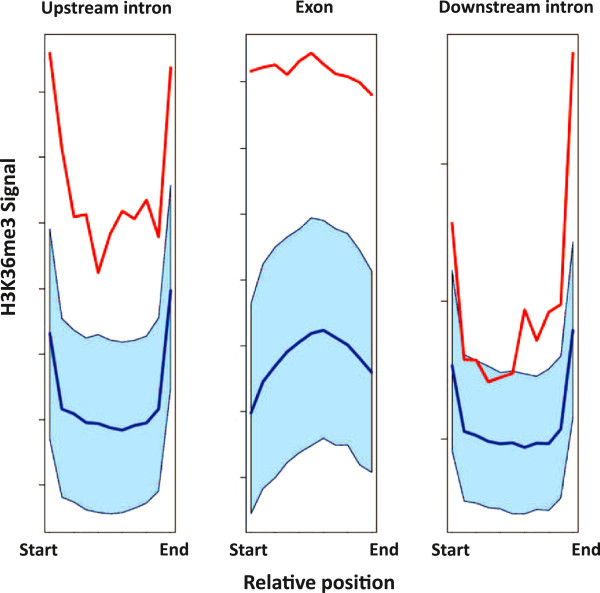
Metagene projections of average H3K36me3 enrichment levels over skipped
exons and surrounding introns. Metagenes based on H3K36me3 levels for
upstream introns, skipped exons and downstream introns show increased H3K36me3
levels in the upstream intron and the exon, but only to minor extent in the
downstream intron, as compared to background. Red
line = transcripts with skipping event. Blue
line = random set of introns and exons with confidence interval
(light blue shaded region). The X-axis is in percentage of total length
(start = 0% and end = 100%) and the Y-axis is the
H3K36me3 signal normalized against input control and the total number of reads
in the sample.